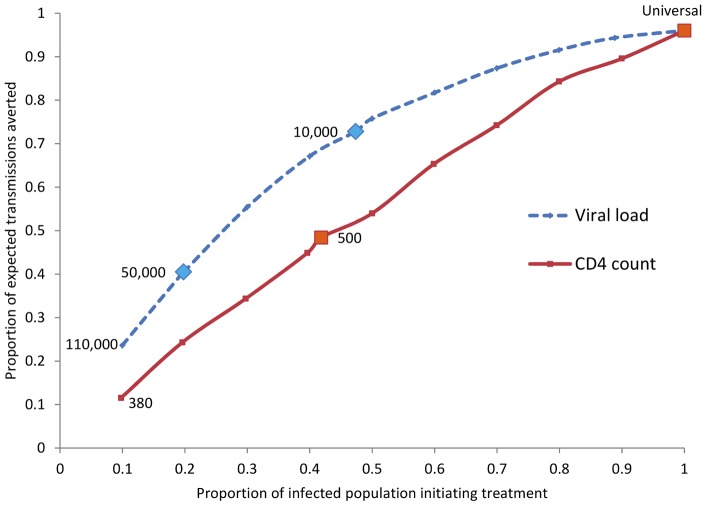
Proportion Initiating Treatment and Expected Transmissions Averted by Decreasing Viral Load and Increasing CD4 Count.The x-axis represents deciles of the population by decreasing viral load or increasing CD4 count; the y-axis represents the proportion of transmissions averted, assuming a 96% reduction in transmission on ART. Overall, the curve based on decreasing viral load begins steeply and later tapers, indicating at the highest viral loads the incremental proportion initiating treatment is small relative to the proportion of infections averted, reflecting the excess of transmissions that occur at high viral loads. The CD4 count curve, by comparison, is linear, suggesting that the prevention benefit associated with increasing the proportion on treatment differs little across CD4 counts in the >350 range.